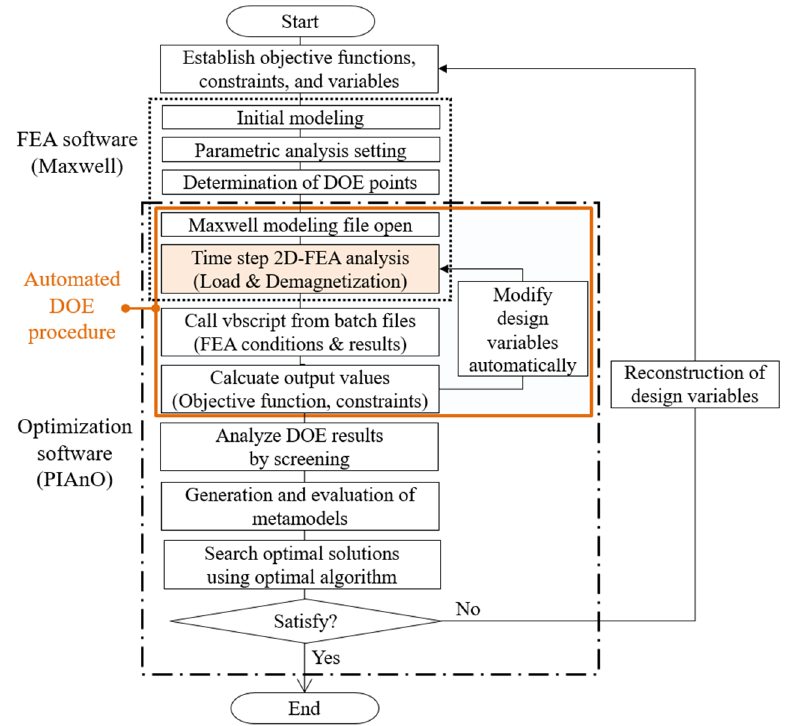
Figure 6. Optimization design process.